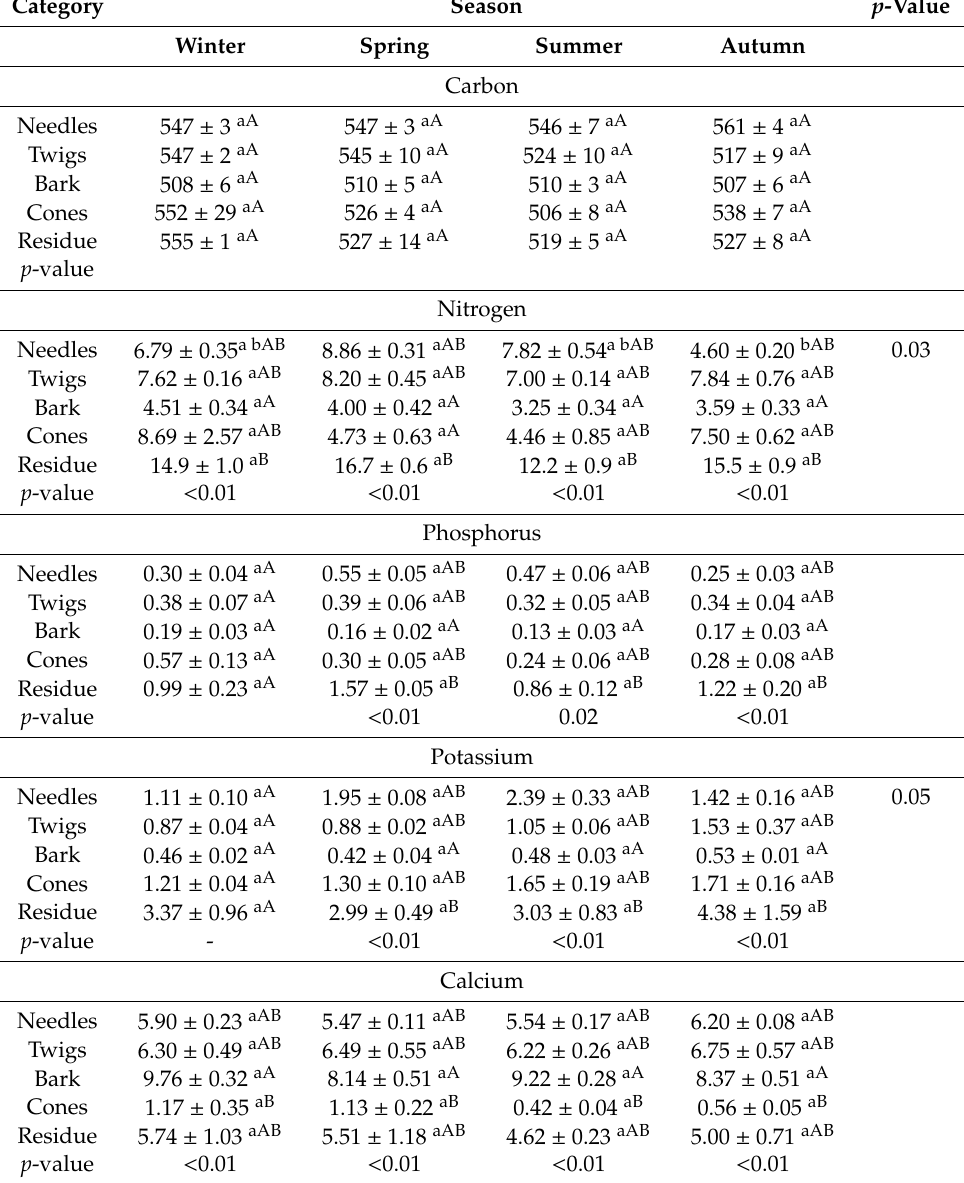
Table 3. Mean contents ( ± SE) of elements in the litterfall categories by seasons (g kg − 1 ) on slope S. p-values were obtained after the Kruskal–Wallis test: values in rows refer to di ff erences in content of an element between litterfall categories in a season; values in the last column refer to di ff erences in content of an element between seasons in a litterfall category (only values of p < 0.05 were shown); lower cases at the SE values refer to rows (di ff erent letters indicate the di ff erence in the element content between seasons), while capital letters at the SE values refer to columns (di ff erent letters indicate the di ff erence in the element content between litterfall